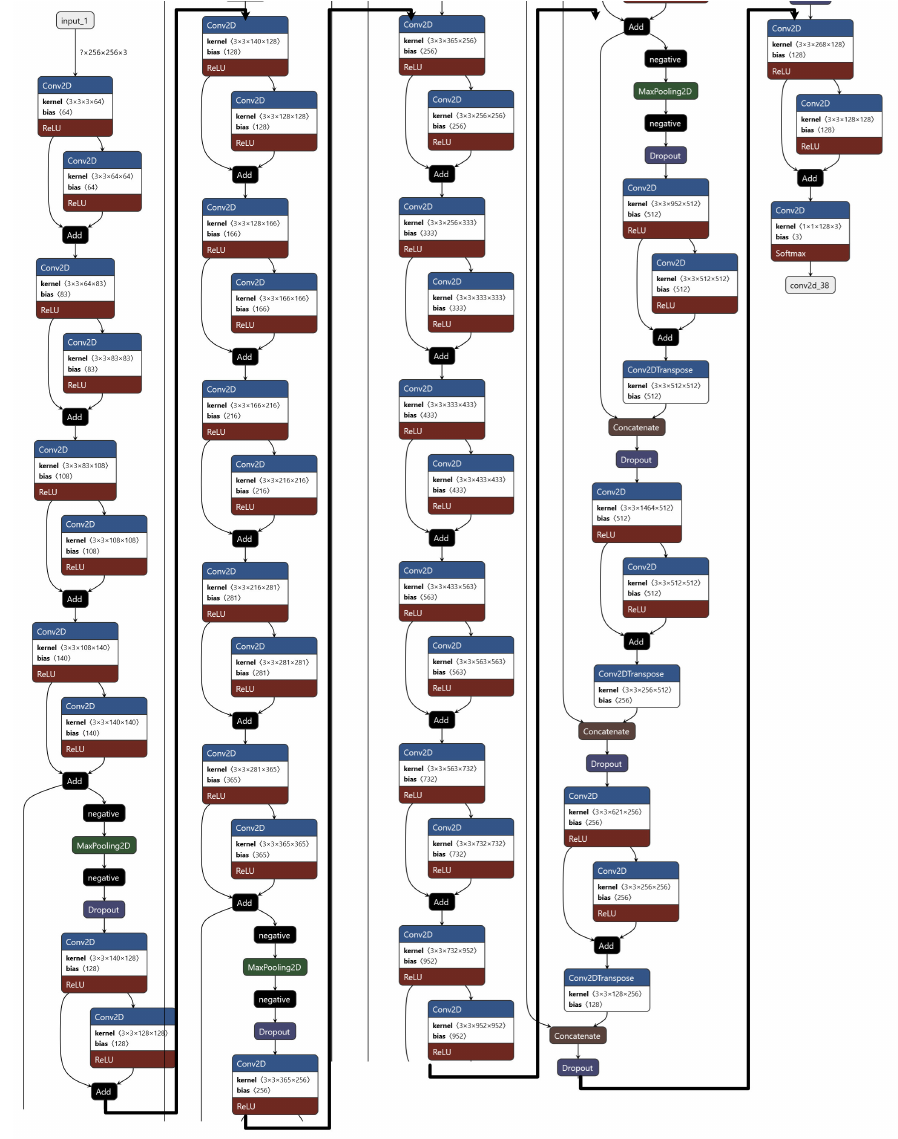
Figure 1. Presented deep learning model architecture is designed for the task of detecting malaria from images of blood samples. It employs an encoder/decoder scheme, with residual layers in the encoder section and U-shaped skip connections in the decoder. The encoder/decoder architecture is a common approach in image segmentation tasks, and involves two separate neural networks to process the input image and generate a detailed output segmentation map. The encoder network is responsible for extracting relevant features from the input image, while the decoder network takes these features and uses them to generate the final output. The inclusion of residual layers and skip connections can help improve the model’s performance by allowing it to more easily learn complex relationships within the data and make more accurate predictions. Residual layers are a type of layer that allows the model to learn the residual mapping between the input and output, rather than trying to learn the mapping from scratch. This can make it easier for the model to learn from the data and can improve its performance. Skip connections, on the other hand, allow for the model to directly incorporate information from earlier layers in the network into the final prediction, which can also help to improve performance. The combination of an encoder/decoder architecture with residual layers and skip connections allows the model to perform precise segmentation of the task and produce accurate results. This makes it a promising tool for detecting malaria from images of blood